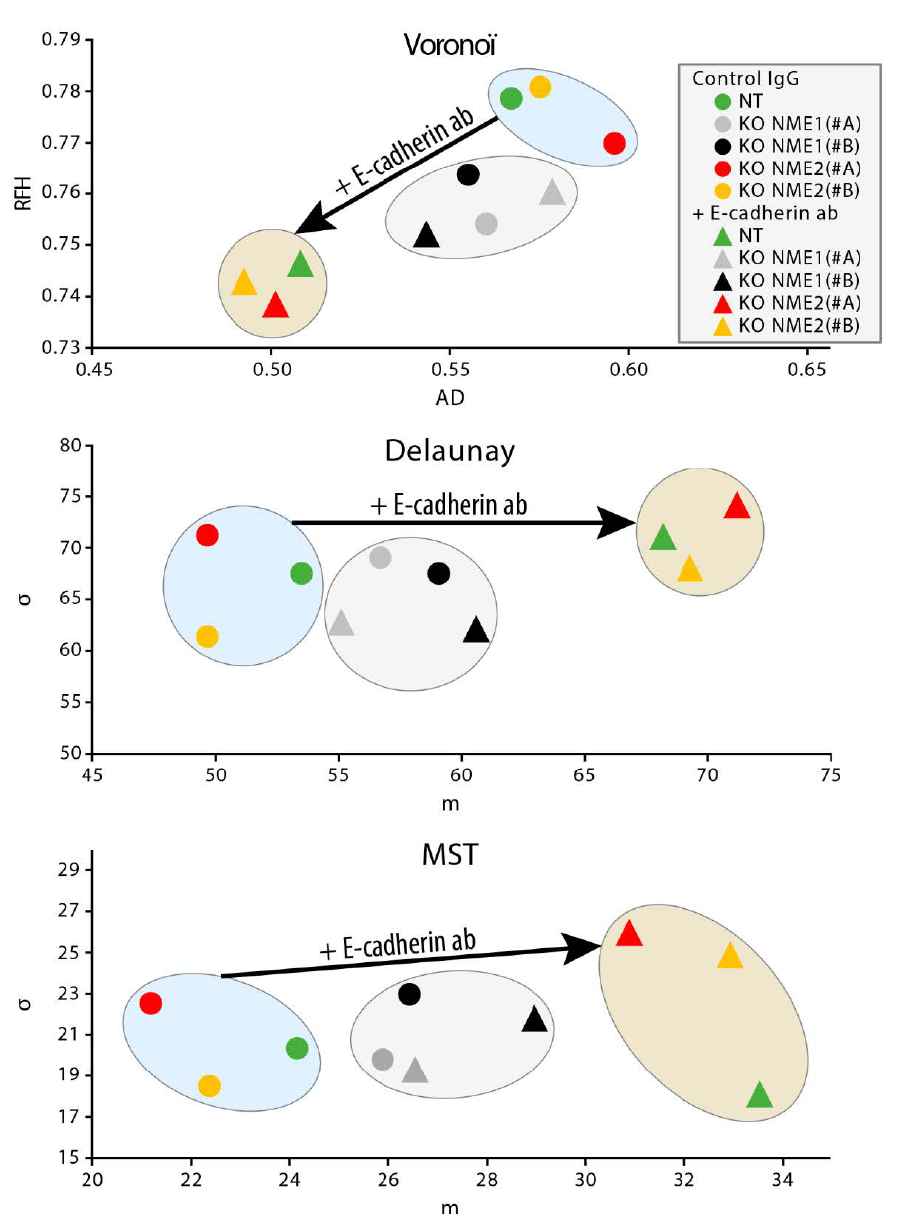
Figure 6. Blocking E-cadherin function does not induce dispersion of NME1-ablated cells. MCF10DCIS.com cells in which the NME1 gene was inactivated (grey and black symbols), the NME2 gene was inactivated (red and yellow symbols) or non-targeting controls (green symbols) were grown as monolayers in the presence of the E-cadherin-blocking antibody or of an isotype-matched control mouse IgG. Phase-contrast images of the monolayers were analyzed 48 h later by using three methods: Voronoi’s partition (top), Delaunay’s graph (middle) and the minimum spanning tree algorithm (bottom). Two parameters were deduced from each method and were plotted against each other: area disorder (AD) versus roundness factor homogeneity (RFH) for Voronoi’s partition, and average length (m) versus standard deviation (d) for Delaunay’s graph and the minimum spanning tree algorithm. The plots show that growth in the presence of the E-cadherin-blocking antibody (triangles) has a large effect on cell–cell interactions of the non-targeting and NME2-ablated cells when compared to growth in the presence of a control antibody (circles), whereas it has a much smaller effect on the NME1-ablated